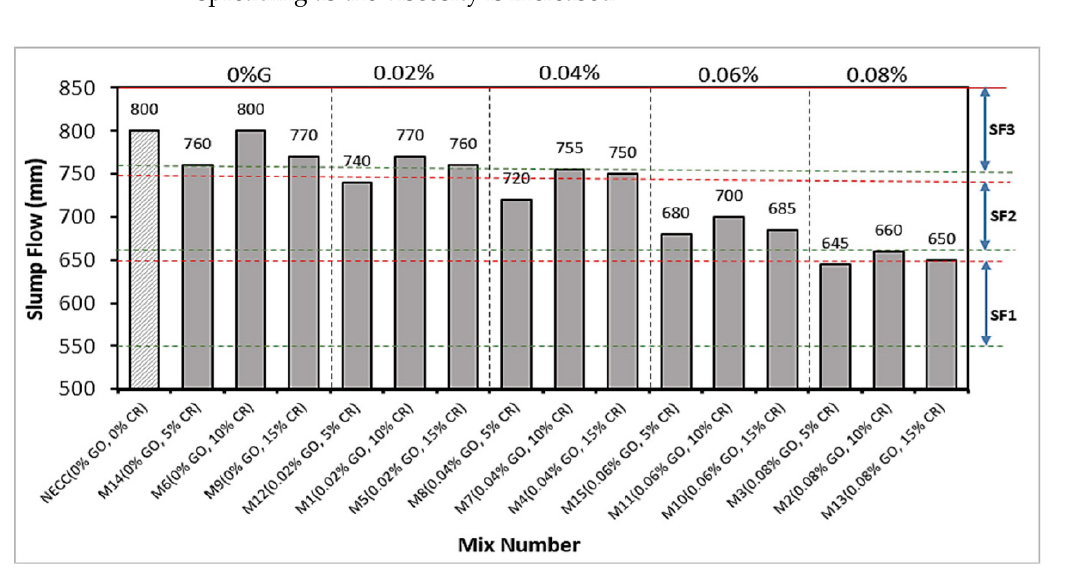
Figure 5. Slump flow values of SC-GO-RECC.